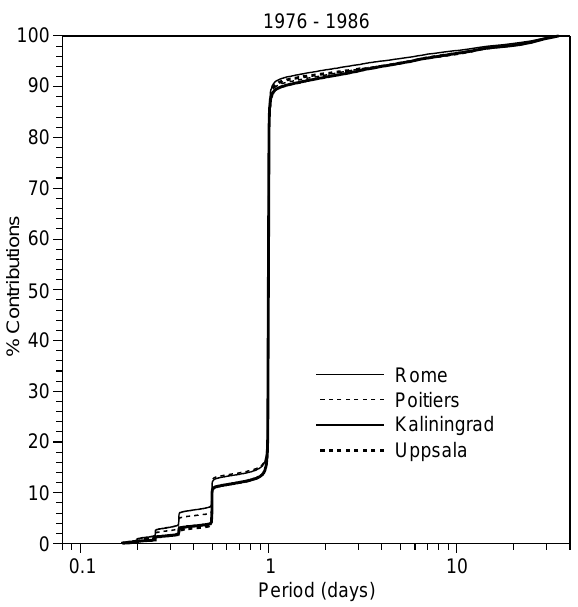
Fig. 2. Integrated percent contributions for periods lower than a given value in the periodic range from 4 h to 35 days for the whole